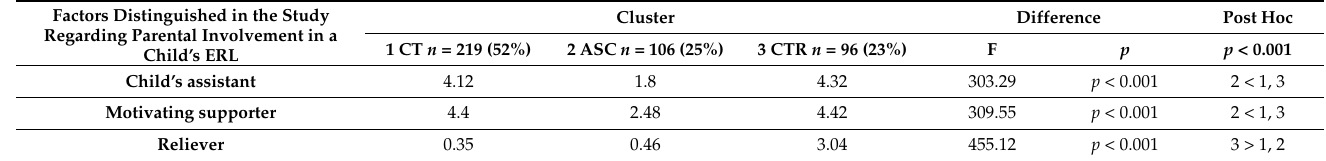
Figure 1. The three types of parental engagement in children’s ERL (Child’s assistant, Motivating supporter and Reliever) in the three distinguished clusters. Table 2. Parents’ involvement in the ERL of their children: comparison of clusters.